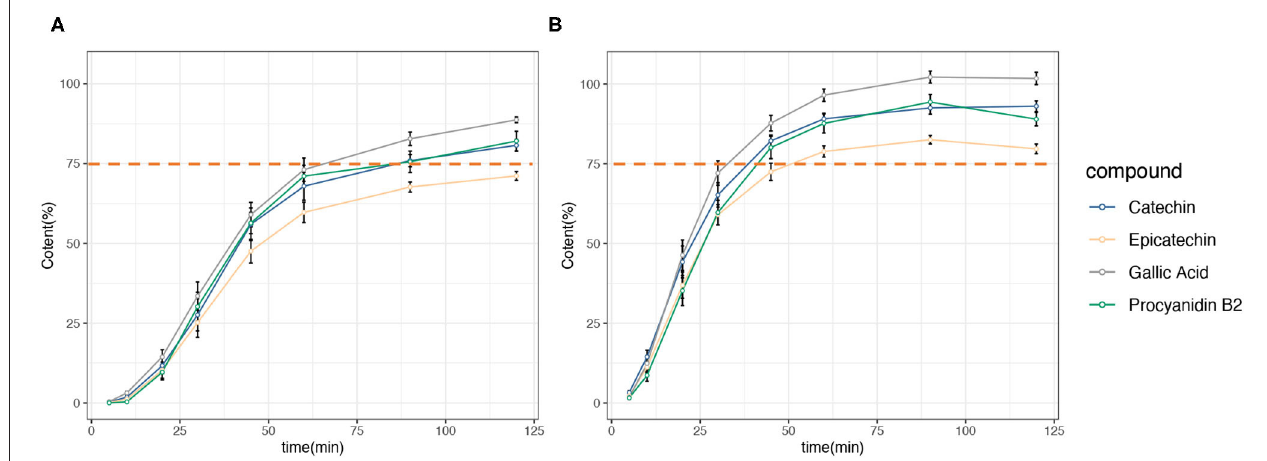
FIGURE 1 | Dissolution profile of grape seed extract (GSE) capsules showing the four major components: catechin, epicatechin, gallic acid, and procyanidin B2. (A) 0.05M acetate buffer (pH 4.6). (B) 0.1N hydrochloric acid (pH